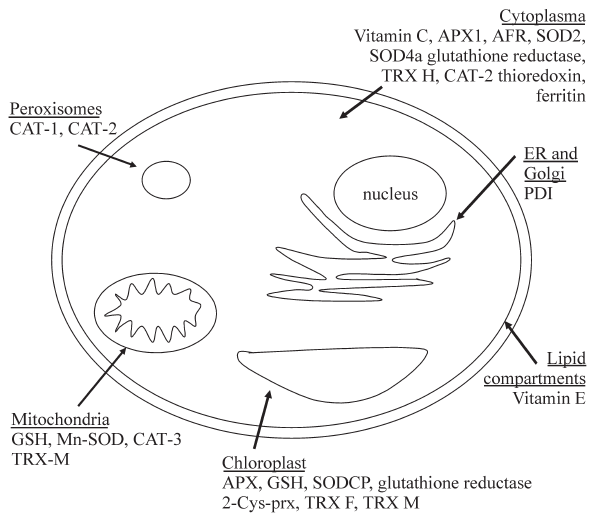
Figure 1 - Overview of the antioxidants found in sugarcane. The location of each antioxidant was based only on sequence similarities and not on ex- perimental data. More details can be found in the corresponding table or in the supplementary data at http://sucest.lad.dcc.unicamp.br/private/min- ing-reports/UI/UI-mining.htm. Antioxidant components, whose cellular location is not known in other organisms, are not represented in this